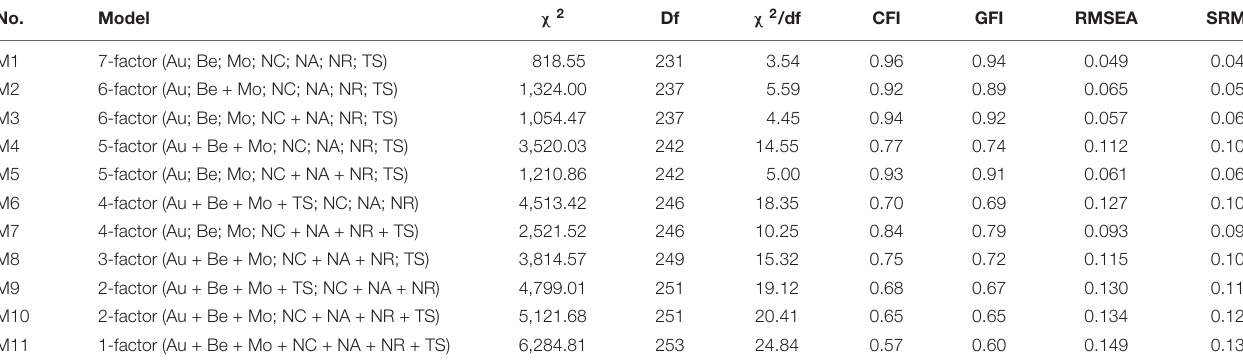
TABLE 1 | The results of discriminant validity test of the relationships among all variables. No.